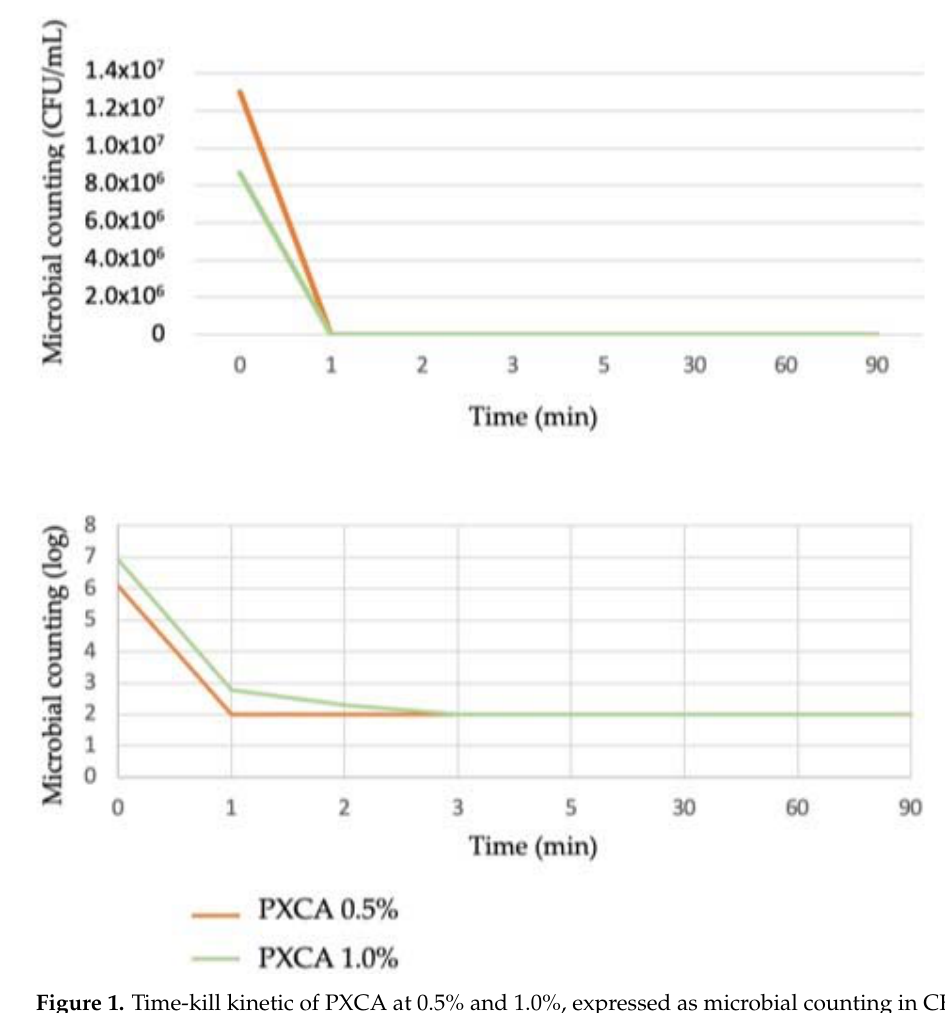
Figure 1. Time-kill kinetic of PXCA at 0.5% and 1.0%, expressed as microbial counting in CFU/mL and log. Time-kill test was performed with C. acnes .